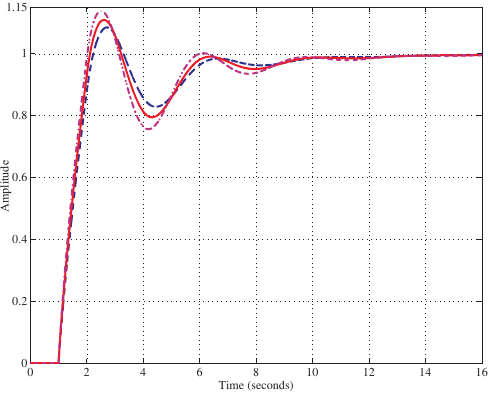
Figure 15. Unit step response in the second example for different fractional orders. Table 2. Characteristics of the step response for 1.1 ≤ D ≤ 1.2 with parameter variations: t r , t s (expressed in seconds), o m (in % values). Changing parameters: K c , ν